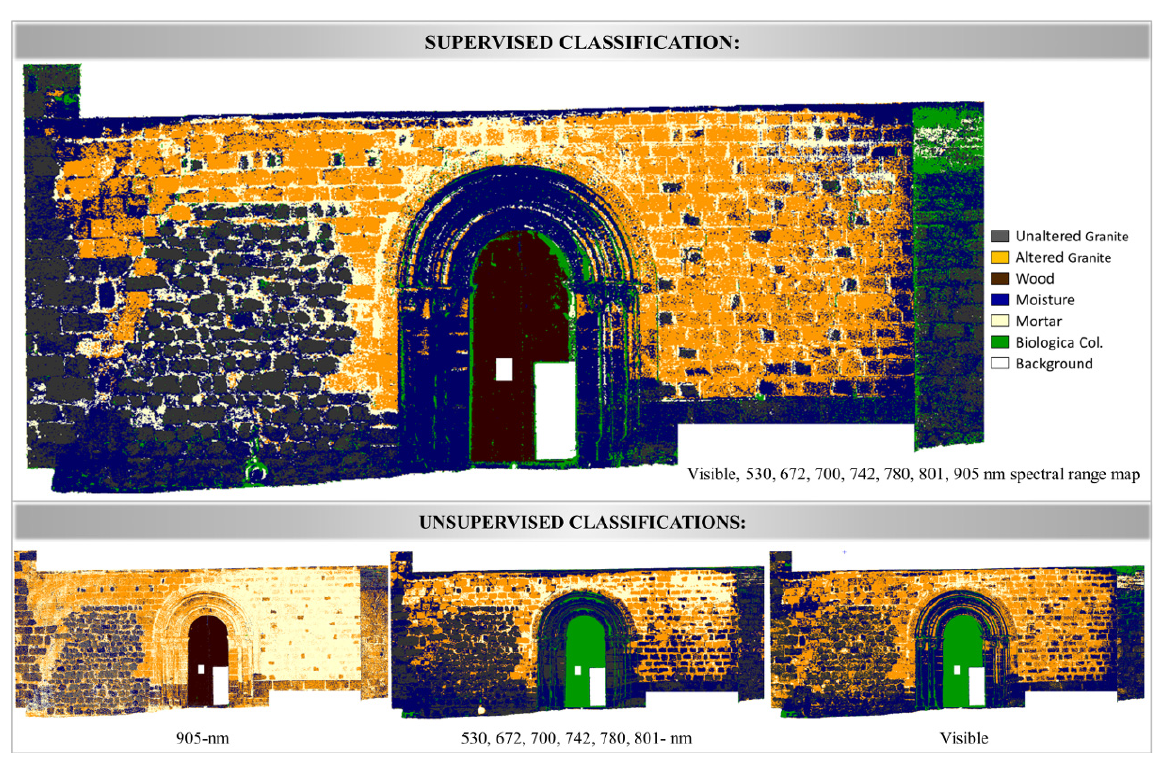
Figure 8. Multisensory map for the 6-classes unsupervised